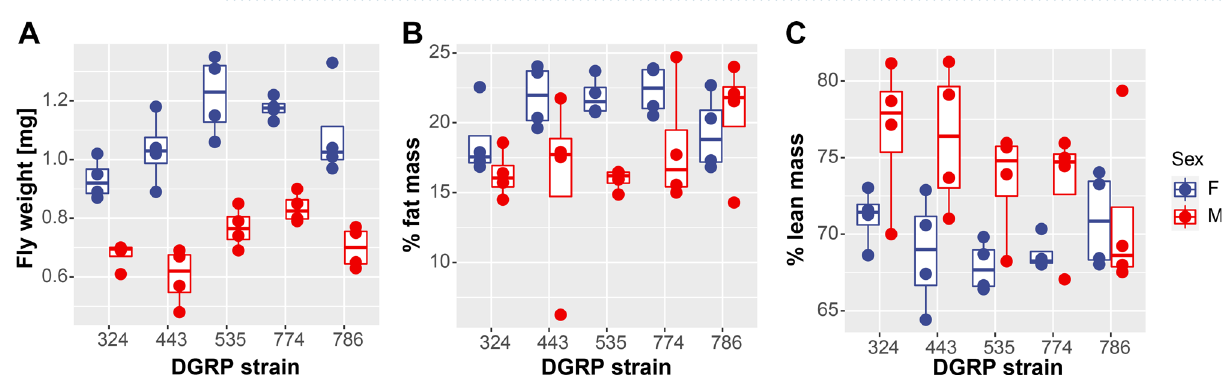
Figure 5. Body composition analysis indicates that heavier animals show higher body fat and less lean mass. Fly weight ( A ), percent fat mass ( B ), and percent lean mass ( C ) as measured by QMR are shown on the Y-axis for five different DGRP strains (X-axis). Data from males is shown in red, data from females in blue. The box plots show the median (horizontal bar) and 25th/75th